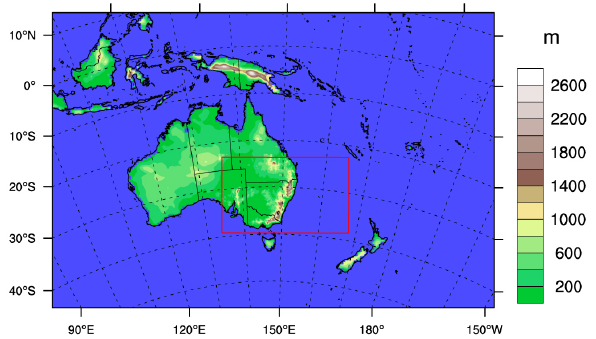
Fig. 1. Topographic map showing the outer and inner (in red) NAR- CliM model domain and state borders. New South Wales is just to the left of centre of the inner